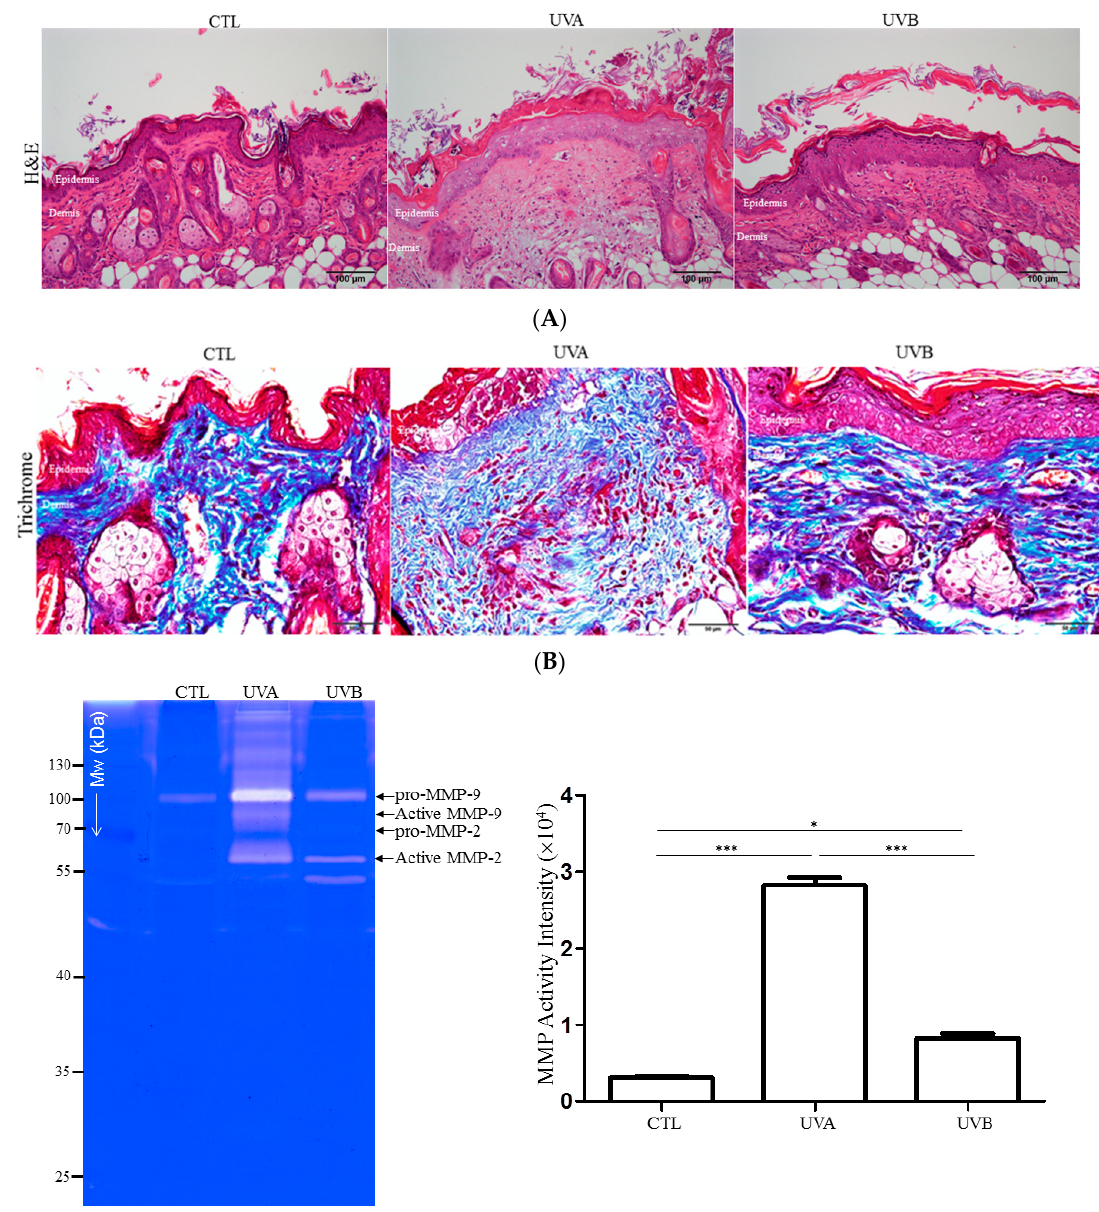
Figure 1. The histologic examination and matrix metalloproteinase (MMP) secretion of the mouse skin exposed to UVA or UVB. ( A ) Histological analysis and assessment of nude mouse skin with hematoxylin and eosin (H&E) staining from control (CTL), UVA-treated, and UVB-exposed samples. Original magnification: 100 × . ( B ) Evaluation of the structure and amount of collagen via trichrome-staining. Original magnification: 100 × . ( C ) MMP expression was assayed by gelatin zymography of control, UVA-, and UVB-applied skin. Quantified data were the mean ± SD of three independent experiments. (* p < 0.05; *** p <